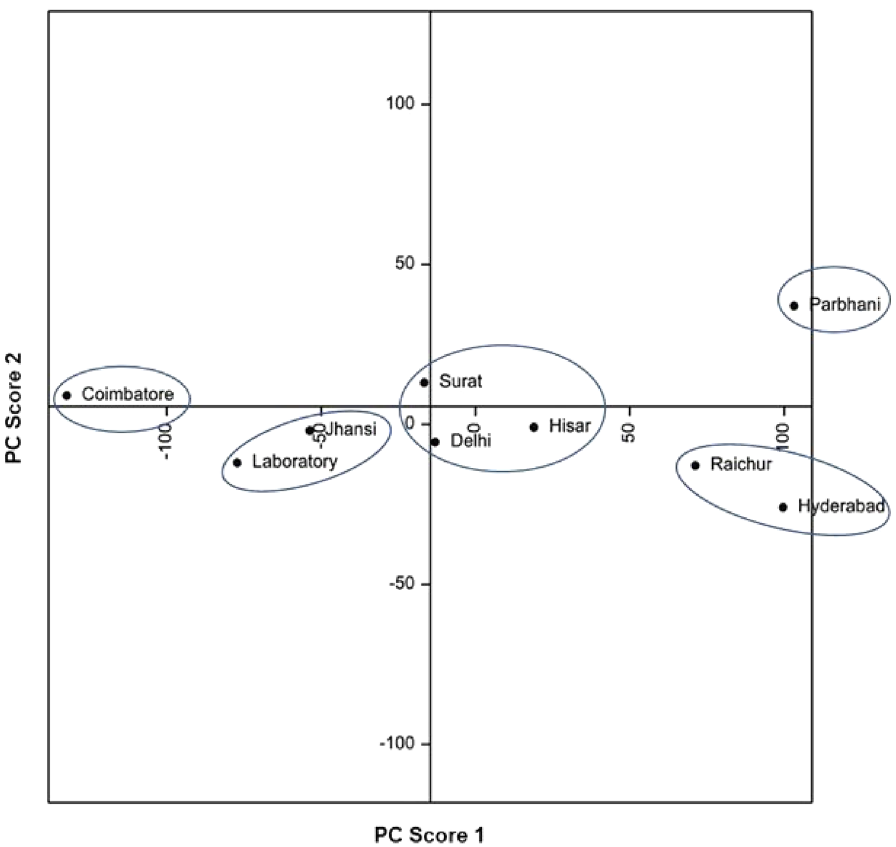
Figure 3. Diversity in different geographical C. partellus populations based on amino